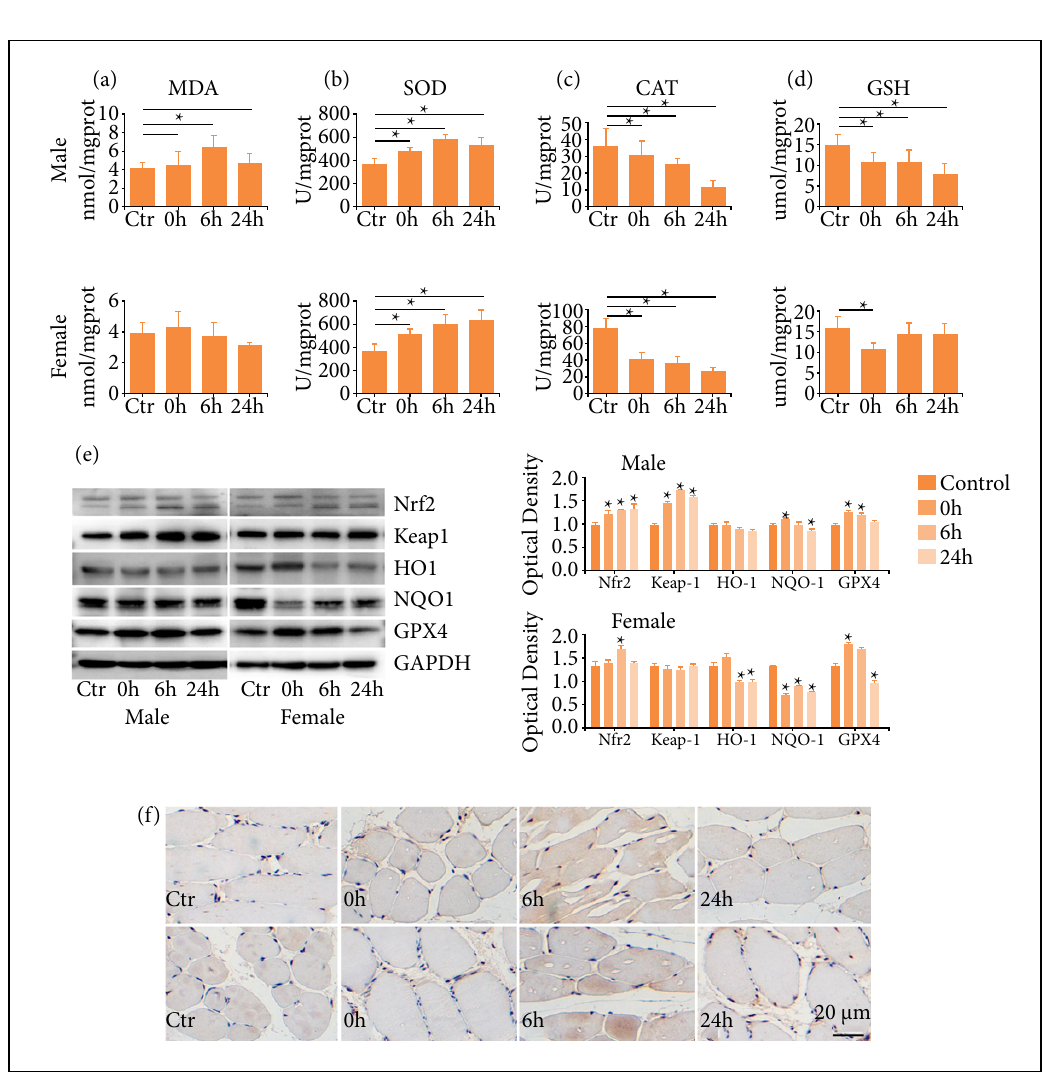
Figure 3 - One-time high-load exercise induce oxygen stress; (a) The concentration of MDA in quadriceps; (b) The activity of SOD in quadriceps; (c) The activity of CAT in quadriceps; (d) The activity of GSH in quadriceps; (e) The expression antioxidant protein in quadriceps; (f) The location of Nrf2. * p < 0.05 compared with the control